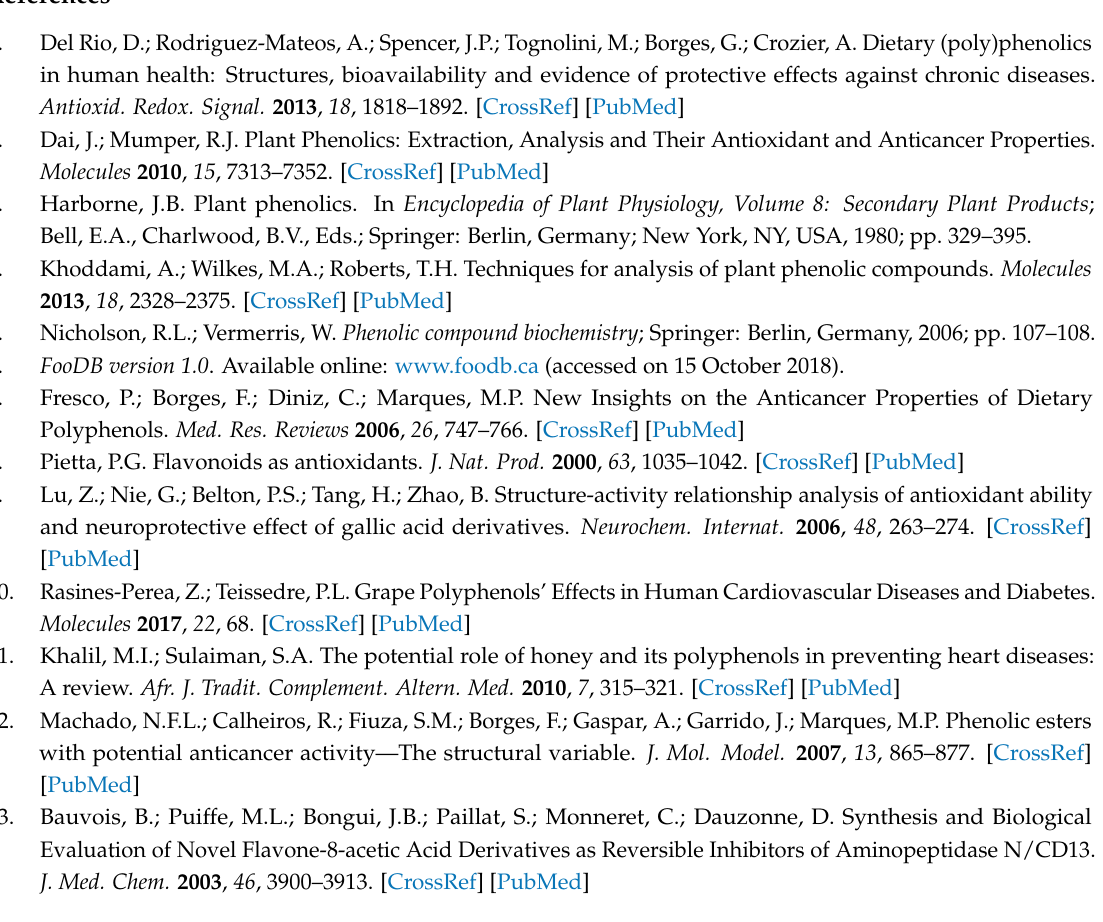
Supplementary Materials: The list of ChemBench models and detailed list of BTL and phenolic datasets with extended results of data analyses (Tables S1–S9) are available as supplementary material